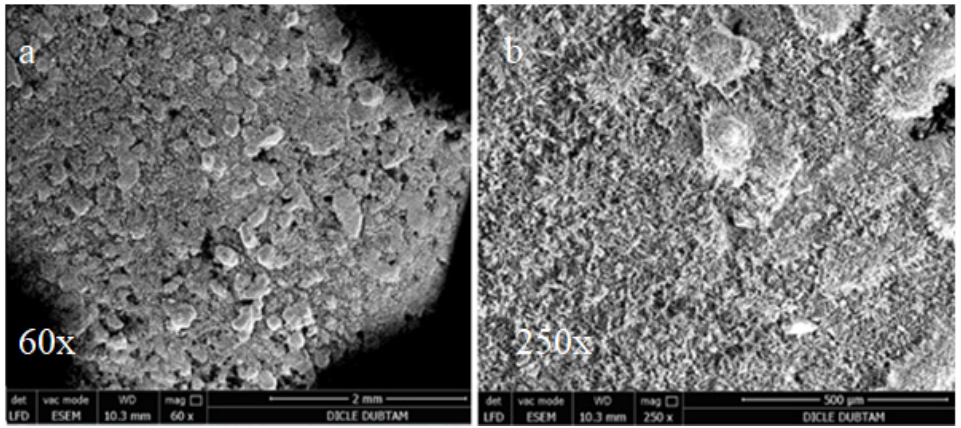
Figure 12. SEM images of SFS replacement bar samples cured 90 days in hydropath: ( a ) 60× ( b ) 250×. For the samples cured for 90 days in sulphate solution, the effects of alkali-silica reactions were observed by SEM as shown in Figures